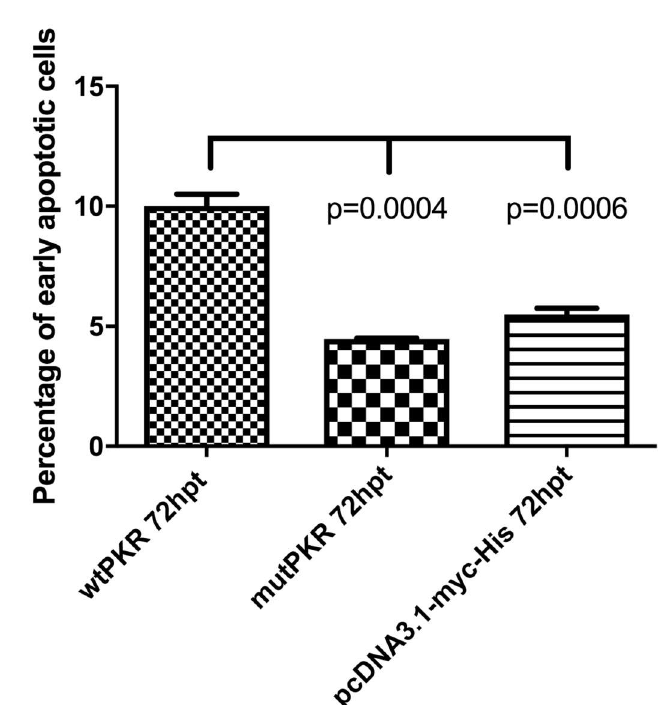
Figure 3. Cytopathic effects (CPE) and the percentage of apoptotic cells in EPC cells transfected with the wtPKR, mutPKR, and pcDNA3.1-myc-His plasmids (controls), respectively, 72 h post transfection. ( a ) Distinct CPE in cells transfected with the wtPKR. Cells transfected with mutPKR and pcDNA3.1-myc-His had insignificant CPE and both showing confluent monolayers, 72 h post transfection. Bar = 10 µ m. ( b ) Flow cytometry analysis of Annexin V-Fluos and propidium iodide staining of apoptotic cells at 72 h post transfection. Each bar represents the average results of two independent experiments, three replicates in each. Percentage apoptotic cells in the wtPKR transfected cells was two-fold higher than in mutPKR cells ( p = 0.0004) and compared to empty plasmid control, at 3 days post transfection (dpt). There was no significant difference between mutPKR and pcDNA3.1-myc-His transfected